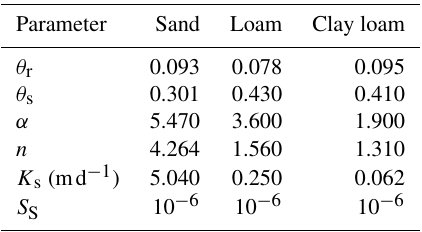
Table 1. Soil hydraulic properties used the Miller et al. (1998) prob-